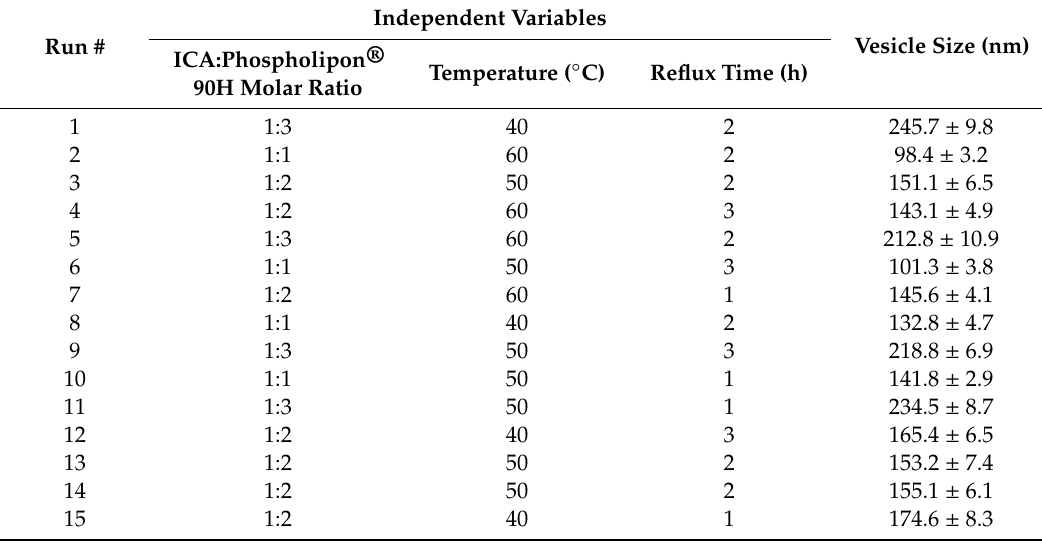
Table 2. Experimental runs of ICA-phytosomes prepared according to Box–Behnken design and their measured mean vesicle